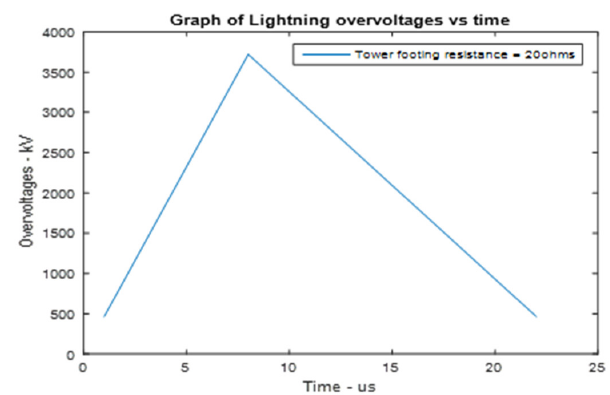
Figure 14. Over-voltages triggered by a 37.5 kA lightning stroke.